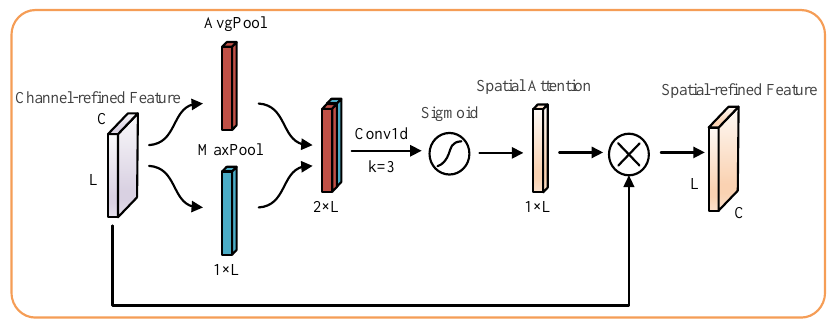
Figure 4. Improved Channel Attention Module.